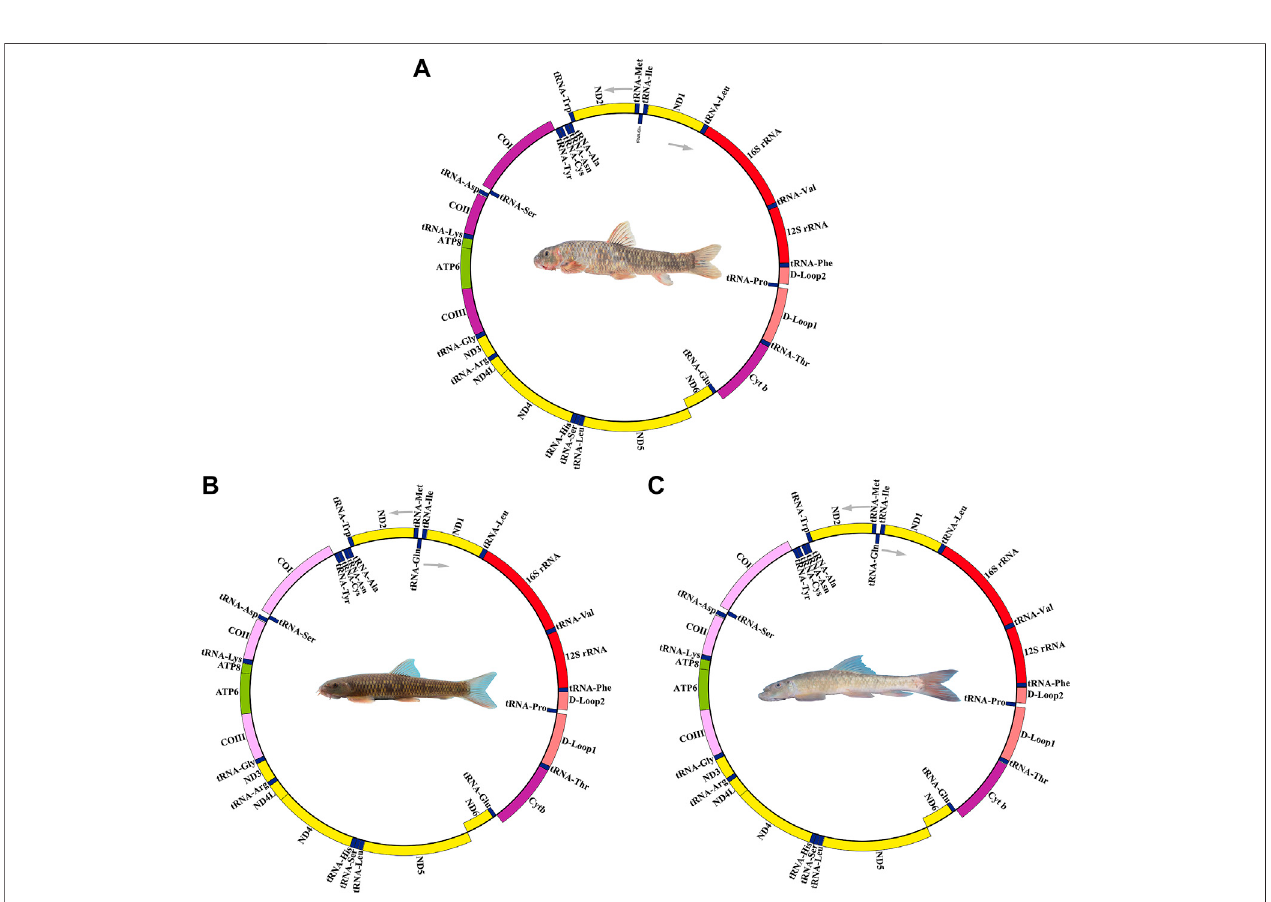
FIGURE1 | The RSCU ofthe mitogenome in (A) Garra dengba , (B) Garra tibetana and (C) Garra yajiangensis . The RSCU ofthethree Garra species mitogenomes show that the usage of NNA and NNC (N for A, T, C, G) was more frequent than NNT and NNG in the G. dengba, G. tibetana, and G. yajiangensis.